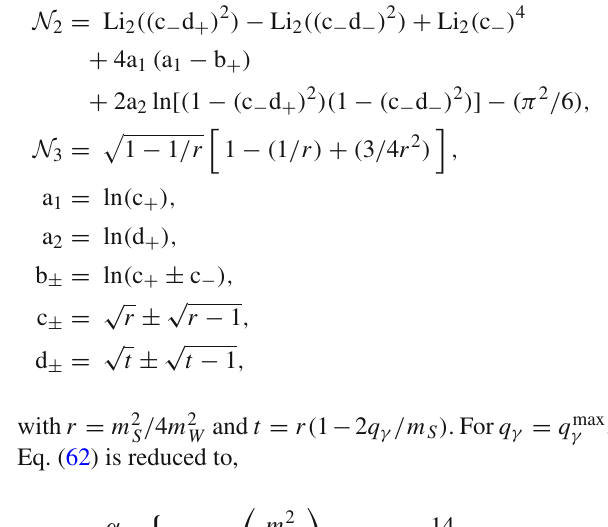
Contribution to the Trilinear Vertices See Fig.